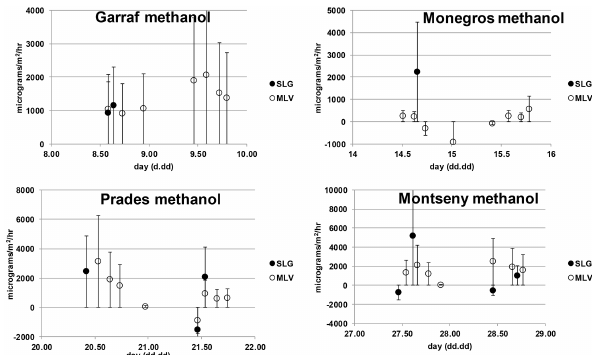
Figure 4. Comparison of the fluxes of methanol estimated by the surface layer gradient and the mixed layer variance